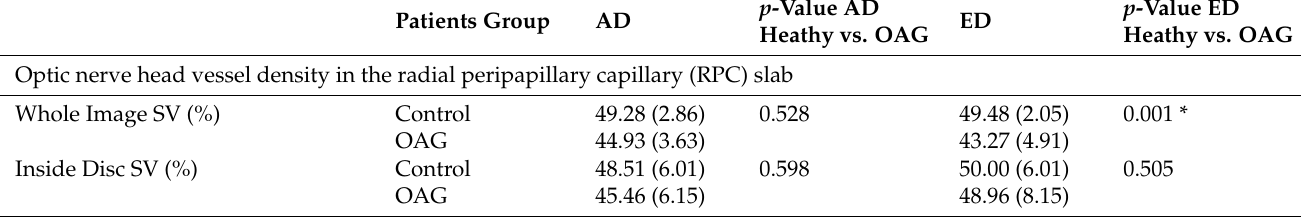
Table 3. Mean and standard deviation of the optical coherence tomography angiography (OCTA) vessel density (VD) and comparisons ( p -values) in control and open-angle glaucoma (OAG) patients of African descent (AD) and European descent (ED). The VD represents the percentage (%) of area occupied by OCTA detected vasculature. The optic nerve head (ONH) VD were assessed via the 4.5 mm HD Angio Disc scan and the percentage of area occupied by OCTA detected vasculature was detected for radial peripapillary capillary slab (from the internal limiting membrane to the nerve fiber layer). The ONH VD measurements are provided from three regions: peripapillary region (defined by two rings of 2 mm and 4mm centered on disc center); inside the optic disc (“Inside Disc”); and entire region (“Whole Image”). The VD are measured for the small vessels (SV) (i.e., with large vessel masking) and for all vessels (ALL). The vessels density information include the radial peripapillary capillary slab density parameters (global and peripapillary hemispheric for both the small vessels and all vessels) and the regional peripapillary vessel density parameters (small vessels only) for the superior, temporal, nasal and inferior quadrants. The central macular vessel density was assessed via the 6.0 mm HD AngioRetina scan in the 1-mm central ring of the ETDRS grid centered on the fovea. ALL: all vessels; IH: inferior hemisphere; IQ: inferior quadrant; NQ: nasal quadrant; RPC: radial peripapillary capillary; SH: superior hemisphere; SQ: superior quadrant; SV: small vessels; TQ: temporal quadrant. * p <